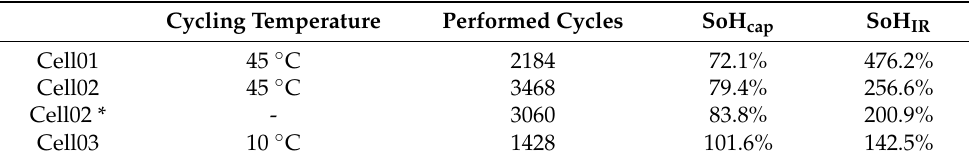
Table 1. SoH of the performed cells due to WLTC cycling. Cycling Temperature Performed Cycles SoH cap SoH IR Cell01 45 ◦ C